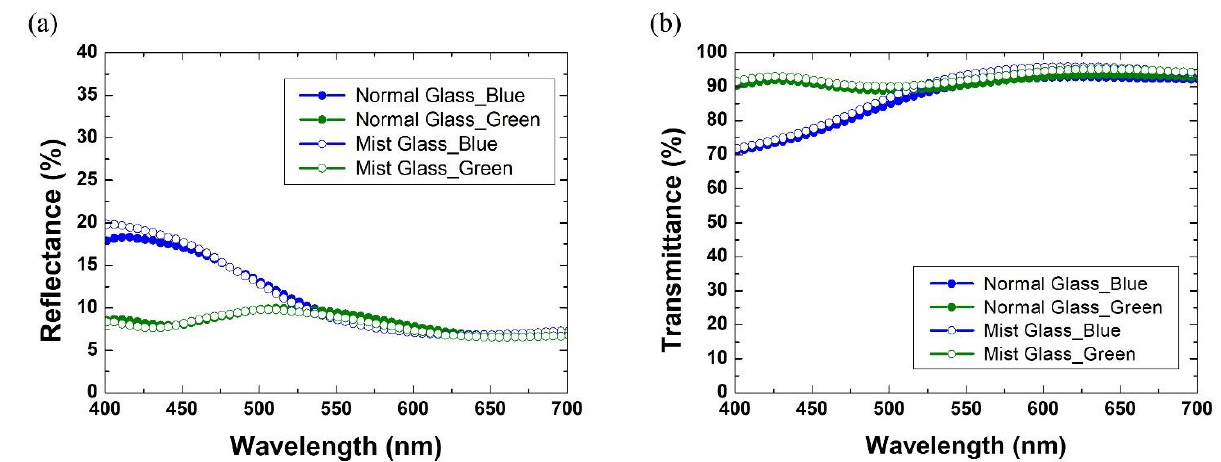
Figure 4. ( a ) Reflectance and ( b ) transmittance spectra of color films spin coated at 1000 rpm on normal and mist glass substrates, respectively. Blue color solutions were deposited on normal glass (blue, solid circle) and mist glass (blue, open circle). Green color solutions were deposited on normal glass (green, solid circle) and mist glass (green, open circle).